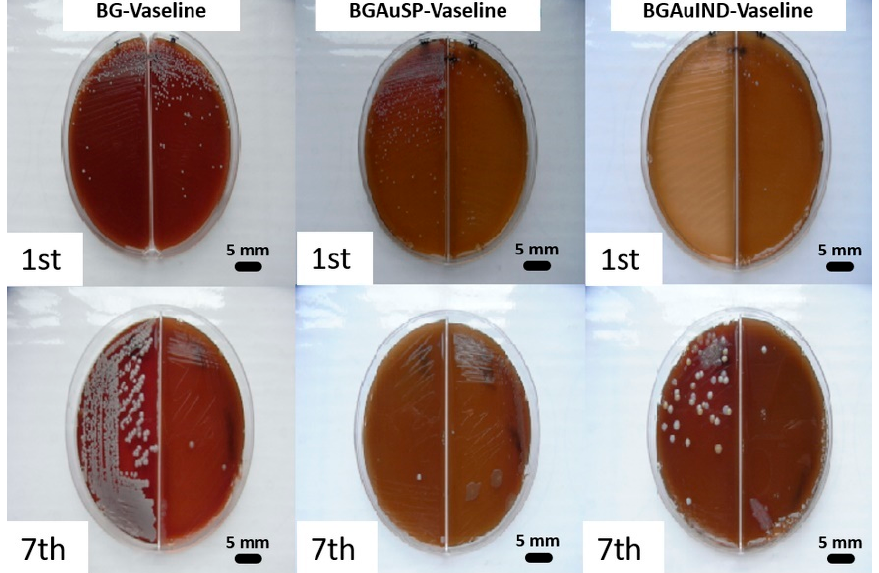
Figure 5. Representative images of bacterial cultures collected from the rats treated with BG-Vaseline, BGAuSP-Vaseline and BG-AuIND-Vaseline ointments on the 1st day of intervention and after 7th days post-surgery.